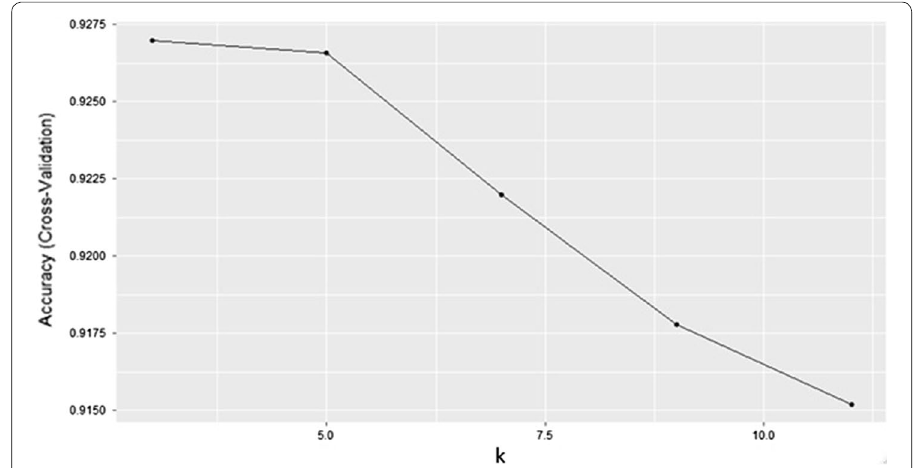
Fig. 2 Optimizing k for the sentiment analysis